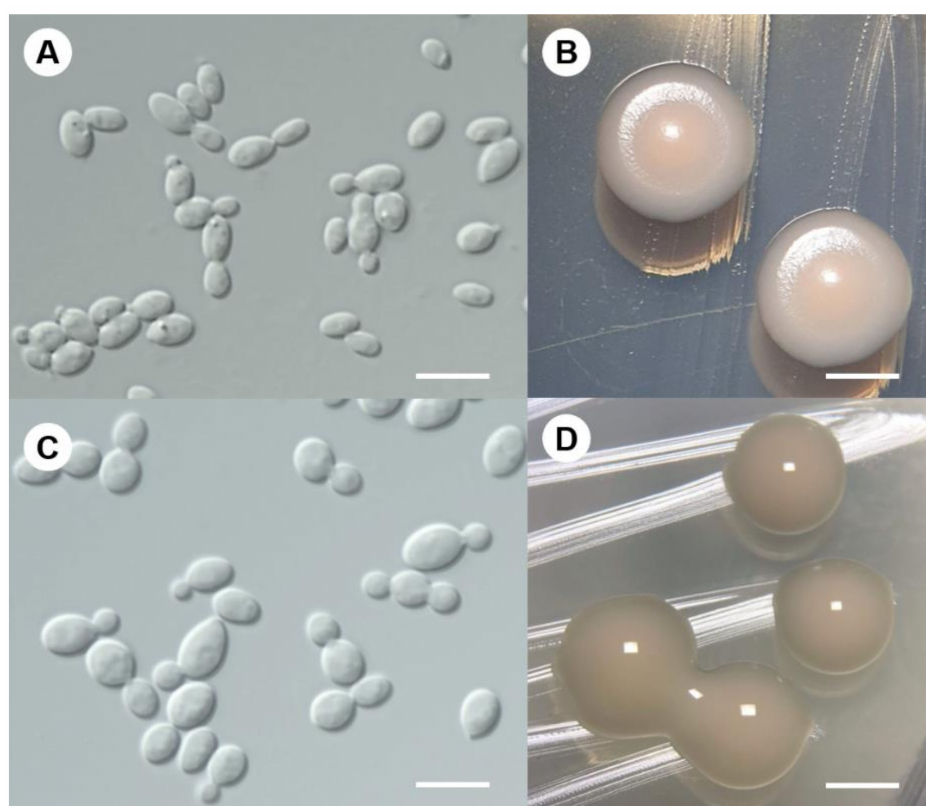
Figure 3. Budding cells and colony morphology on YM agar after 3 days at 25 ◦ C. ( A , B ) Savitreella phatthalungensis (holotype DMKU-PAL186); ( C , D ) Goffeauzyma siamensis (holotype DMKU-PAL39).